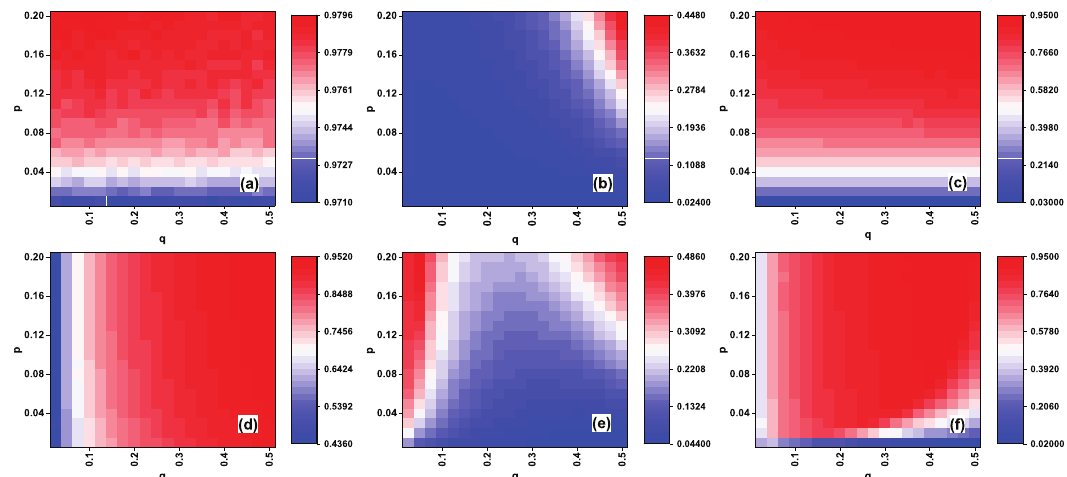
Fig 2. (Color online) The effectiveness of the EigenRank algorithm under random rating attack for the MovieLens data set: (a) ; (b-c) Δ AUC , the comparison of AUC between EigenRank algorithm and IBeta method (b), Vote the AUC values AUC e e e Aggregation method (c); (d) the recall R c ( L ); (e-f) Δ R c ( L ), the comparison of recall between EigenRank algorithm and IBeta method (e), Vote Aggregation method (f). The parameters q and p denote the ratio and the activity of spammers, respectively. q ranges from 0.025 to 0.5 in increments of 0.025 and p ranges from 0.01 to 0.2 in increments of 0.01. One observes both the AUC R c ( L ) of the EigenRank algorithm exceed the ones obtained by the IBeta method and Vote Aggregation method for different ( p , q ).